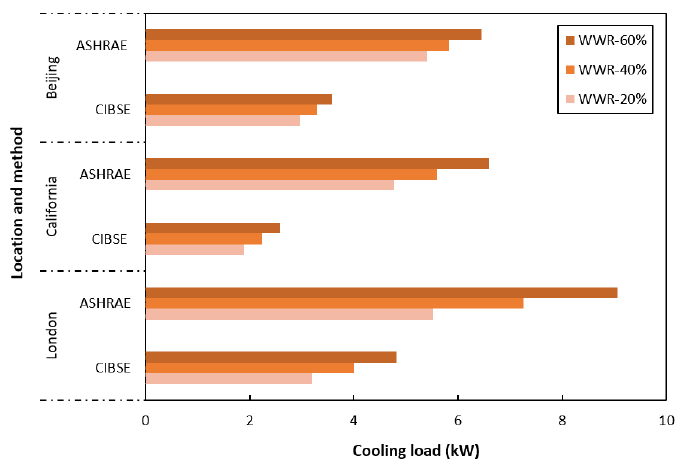
Figure 4. Southern wall window-to-wall ratio impacts on peak heat gains.